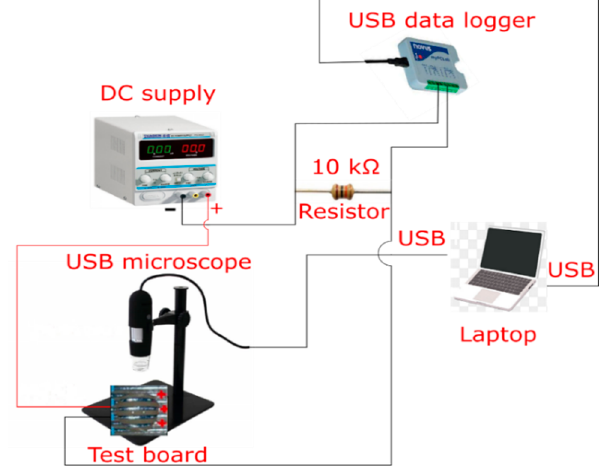
Figure 1. Schematic of the measuring platform for ECM WD tests.